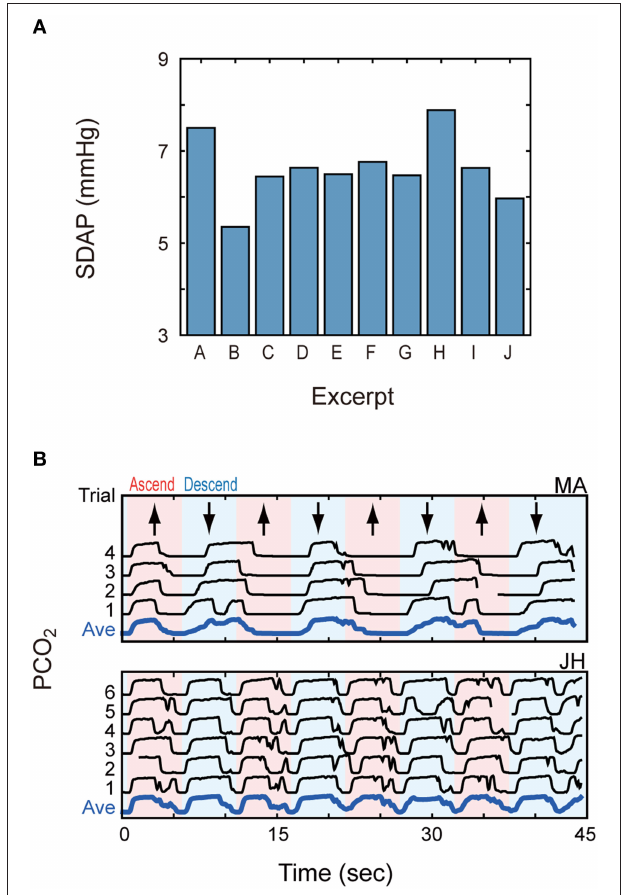
FIGURE 5 | Inter-trial consistency of breath pattern. (A) Standard deviation of inter-trial average PCO 2 values (SDAP) is plotted for every music excerpt. (B) PCO 2 patterns of two participants for Excerpts A (scale) are shown. The pink and blue backgrounds indicate upward and downward sequences, respectively. These participants exhibited quite consistent and structured breath patterns for this monotone piece. FIGURE 6 | Distribution of first expiration time. (A) Histogram of the